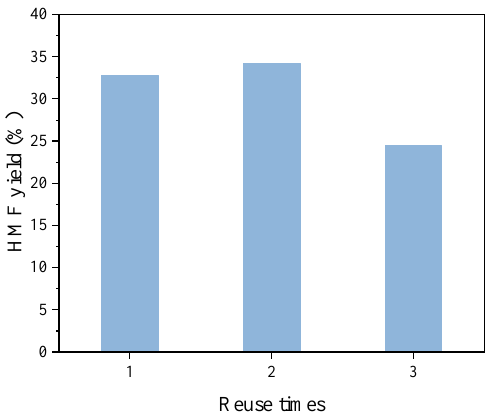
Figure 8. Reuse potential of SO 42− −B 2 O 3 /ZrO 2 : 0.40 g glucose, 0.20 g catalysts, 40 mL water, at 190 °C, for 60 min.